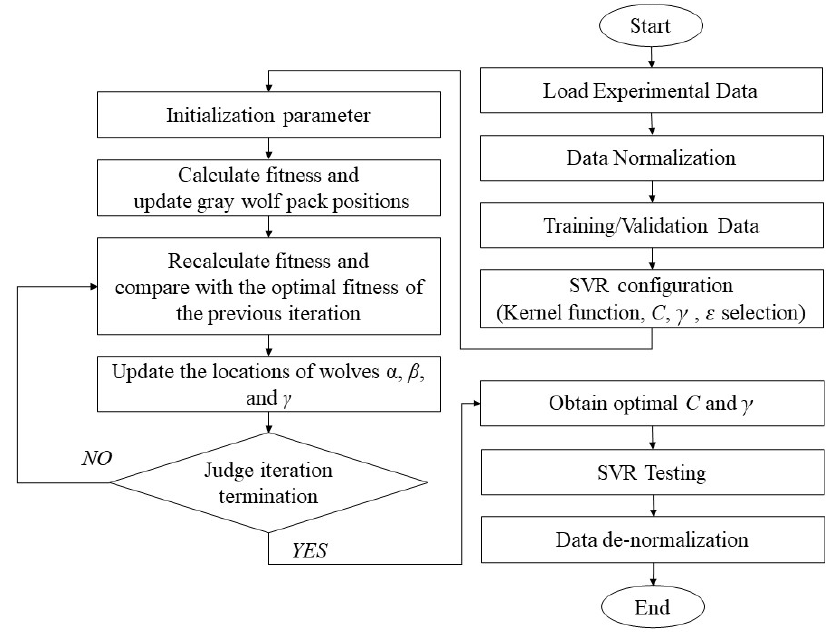
Figure 6. The structure of the SVR-GWO model.